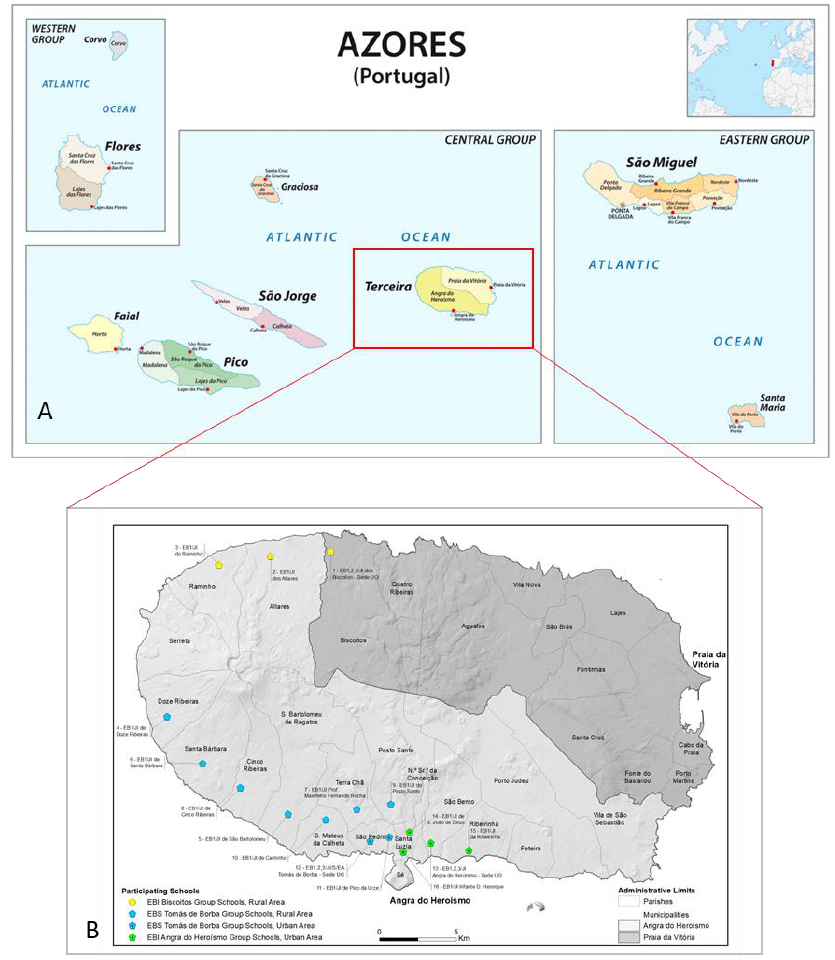
Figure 1. Location maps of the Azores archipelago ( A ) and Terceira Island ( B ). The participating schools are represented by dots (green, blue, and